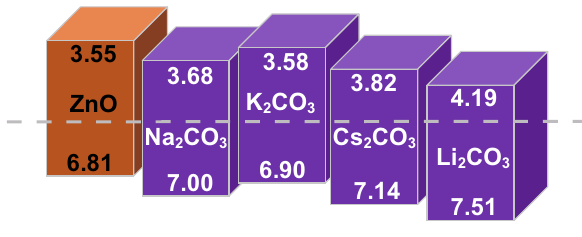
Fig. 12 Energy levels of ZnO ripple layers incorporated with various metal carbonate materials. Reproduced with permission from